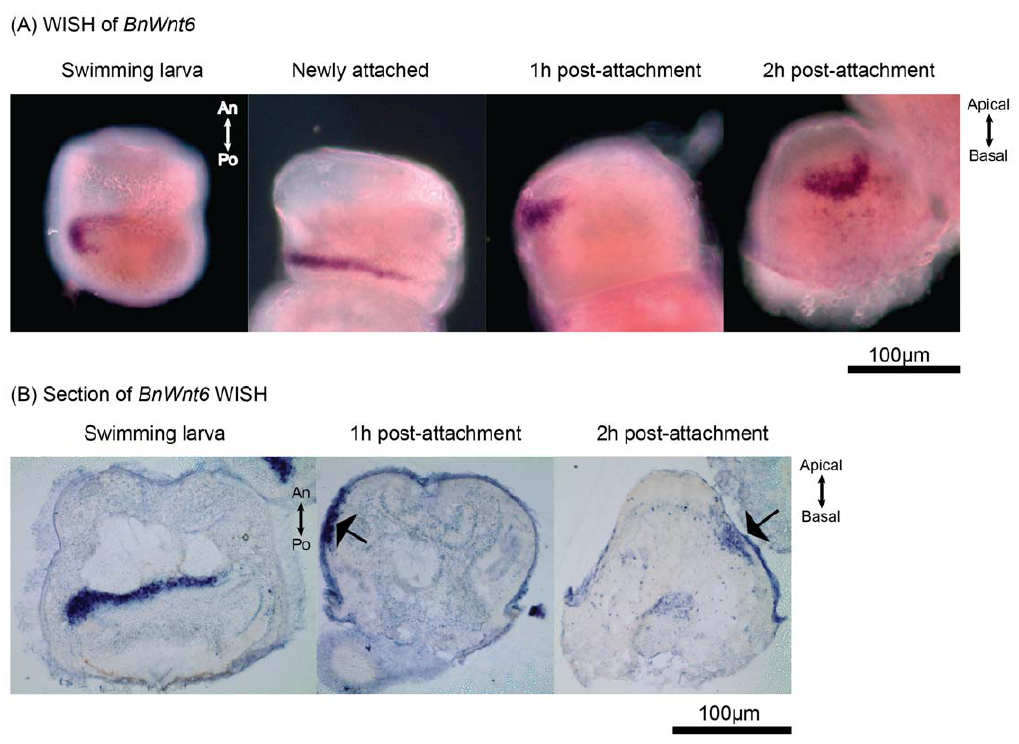
Figure 3. Expression BnWnt6 in the larval and early pre-ancestrula stages. ( A ) WISH and ( B ) a representative section of WISH showing BnWnt6 is originally expressed at the dorsal side of the wall region of the internal sac. BnWnt6 -expressing cells become part of the epidermis on the apical half after larval attachment. An: anterior; Po: posterior.